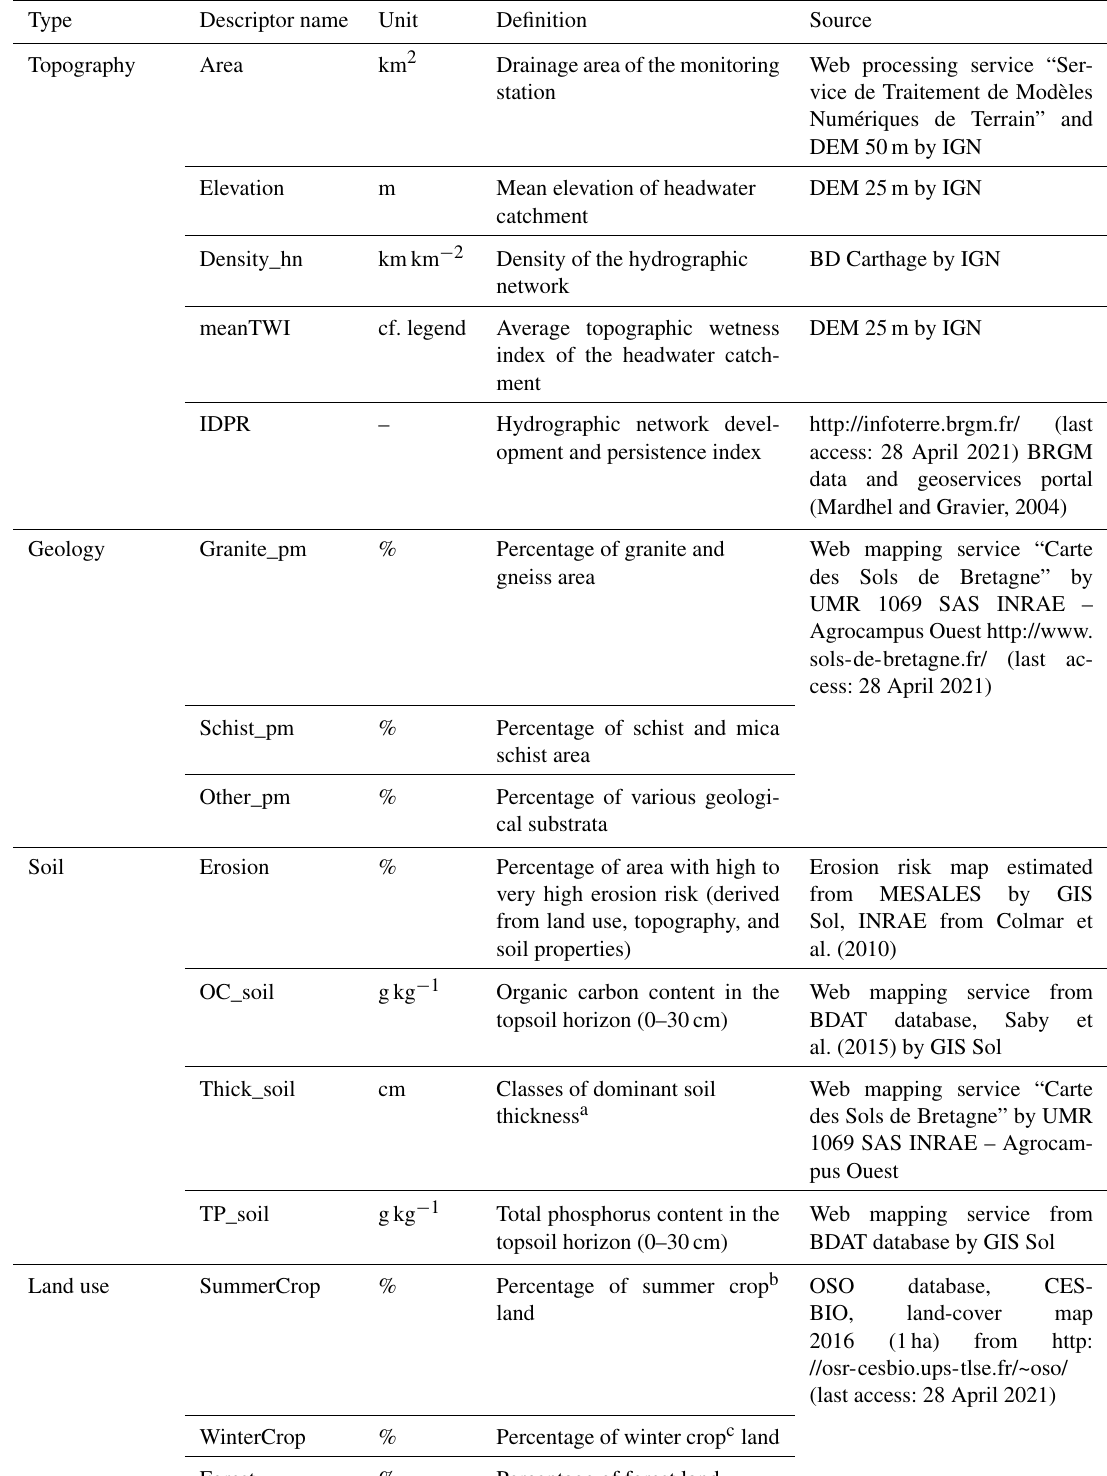
Table 1. Headwater catchment descriptors identified as potential explanatory variables of spatial variability and temporal variation in dis- solved organic carbon (DOC), nitrate (NO 3 ), and soluble reactive phosphorus (SRP) in stream and river water. meanTWI = log α α is the drainage area (ha) and β is the downstream slope (%) (Merot et al.,